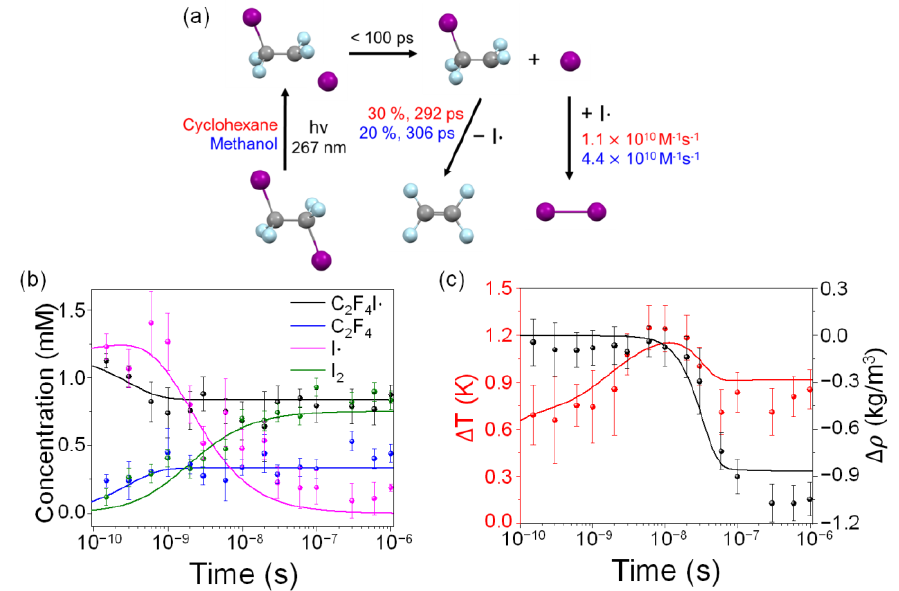
Figure 4. ( a ) Reaction mechanism of C 2 F 4 I 2 photodissociation in cyclohexane determined in this study. Kinetic parameters for the reactions in cyclohexane and methanol are marked in red and blue, respectively. ( b ) Time-dependent concentration changes of chemical species involved the photodis- sociation reaction of C 2 F 4 I 2 in cyclohexane. ( c ) Time-dependent changes of solvent temperature (red) and density (black) induced by photodissociation of C 2 F 4 I 2 . Solid lines were obtained from optimized global fits based on kinetic models, and symbols were obtained from individual fits of experimental difference scattering curves at various time delays.